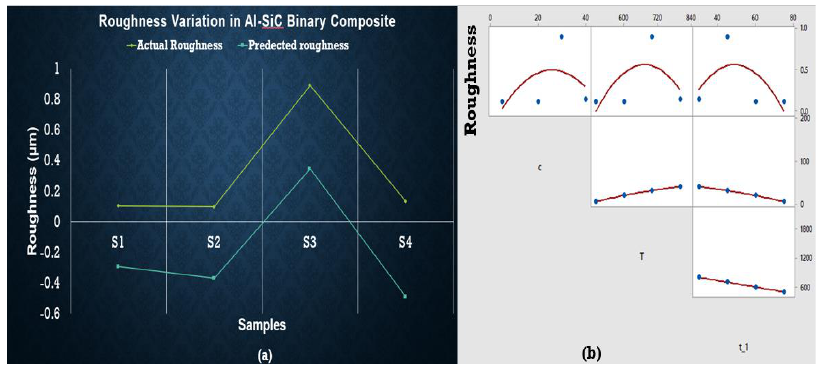
Figure 8. ( a ) Regression plot for Al-SiC showing overlapping of actual and predicted roughness values points (yellow line presents actual value of hardness and blue line shows predicted values). ( b ) Matrix plot showing the individual relationship between roughness and input variables for Al-SiC.